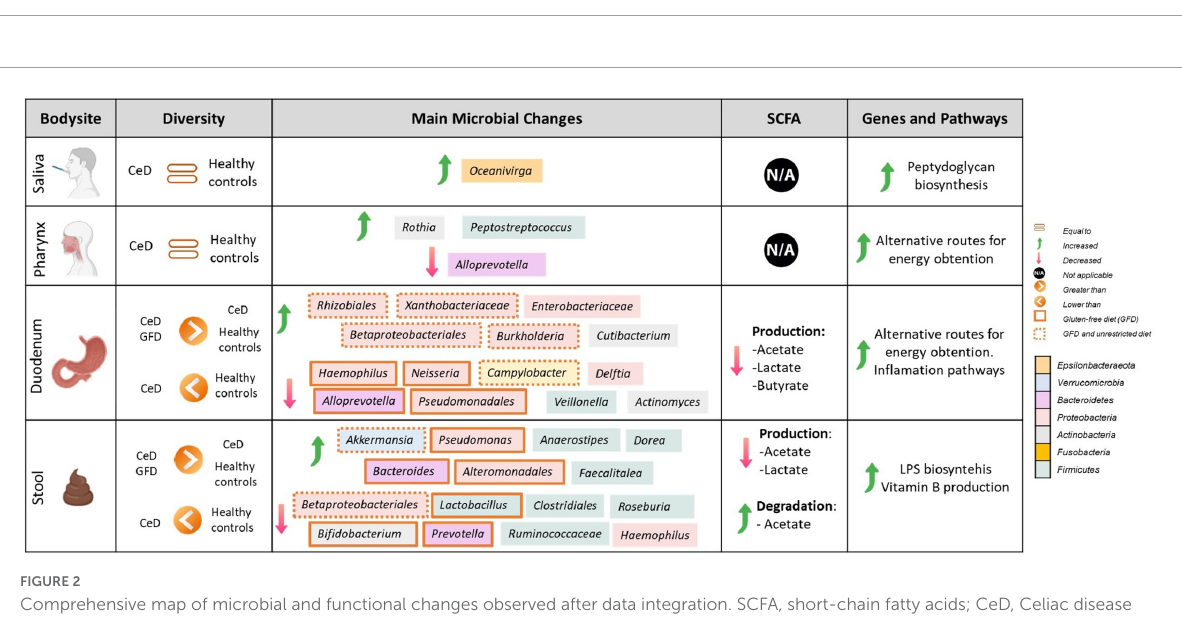
FIGURE1 Shannon (A) , Simpson (B) , and Chao1 (C) diversity indices for (1) the pooled samples in cases and controls for each sampled tissue according to diet. The p -value was calculated using the Wilcoxon test in (A,B) and the Welch’s t-test in (C) . The limits of the rectangle indicate the 25th and 75th percentiles and the horizontal bars indicate the median, in (C) , the median equals average. Vertical bars indicate upper and lower distribution limits, and dots represent mild outliers. **** P < 0.0001.